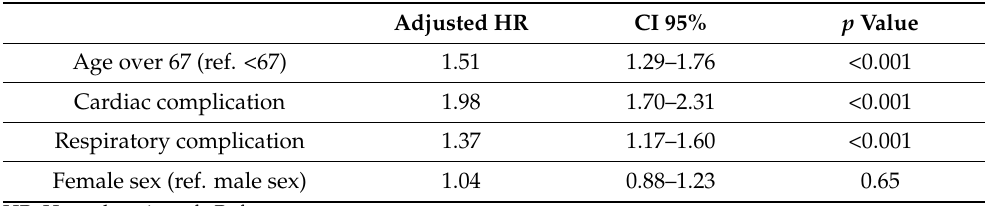
Table 3. Factors associated with 30-day mortality.